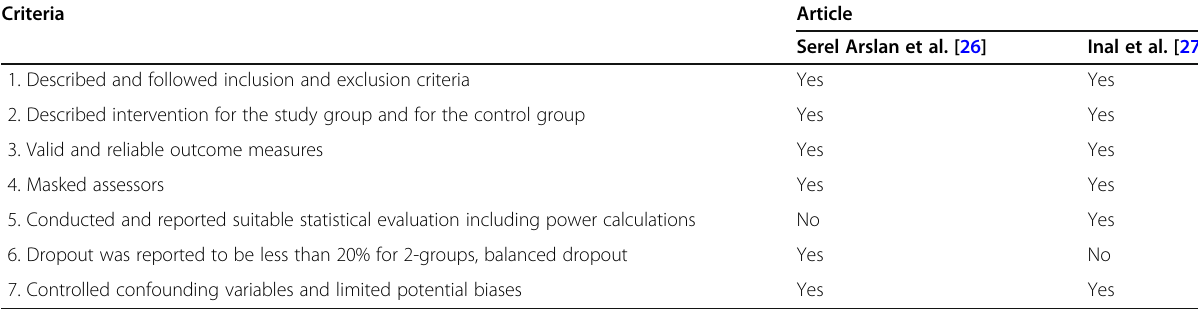
Table 2 Critical appraisal by AACPDM